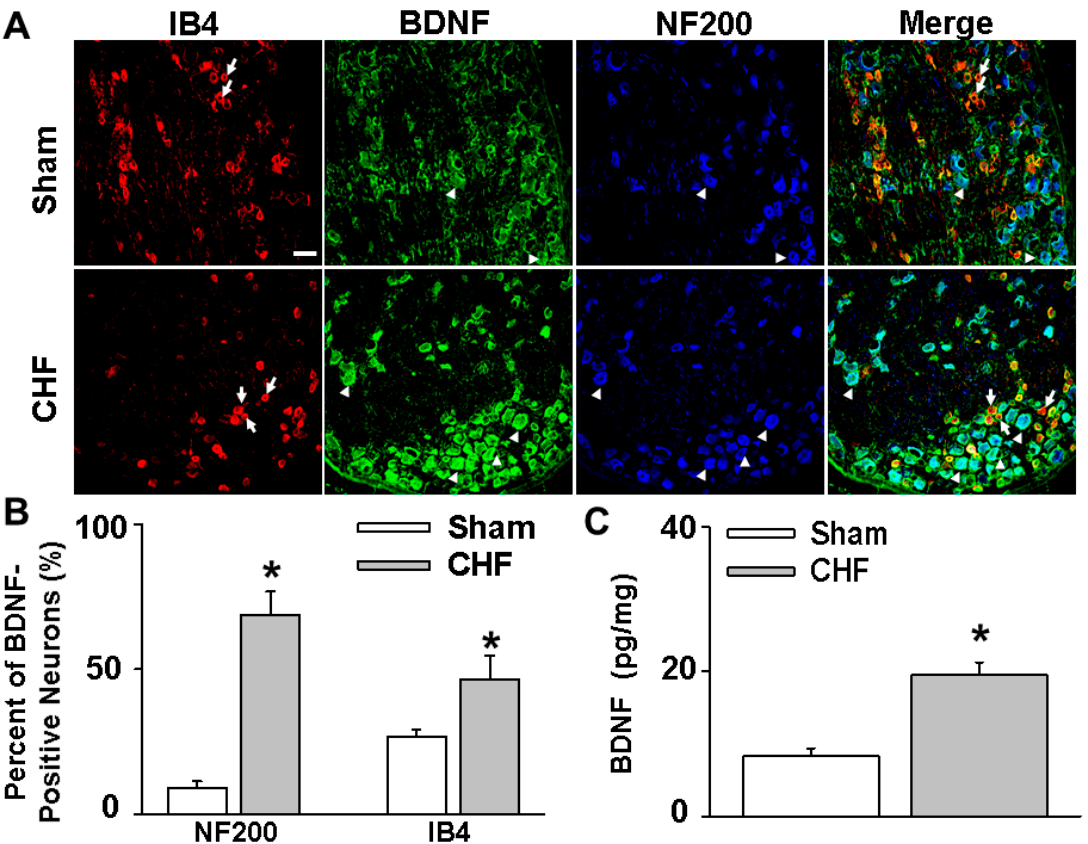
Figure 1. ( A , B ) Brain-derived neurotrophic factor (BDNF) expression in lumbar dorsal root ganglia (DRGs) measured by immunofluorescence in sham and CHF rats ( n = 5/each). Isolectin B4 (IB4, red color), a C-fiber neuron marker; NF200 (blue color), an A-fiber neuronal marker. White bar = 50 µ m. White arrows point to the small IB4-positive neurons without BDNF staining (green color). White arrowheads represent double staining of BDNF with NF200, which are medium or large sized soma. ( C ) BDNF expression in lumbar DRGs measured by ELISA assay in sham and CHF rats (mean ± SE. n = 6/each). * p < 0.05 vs. sham.